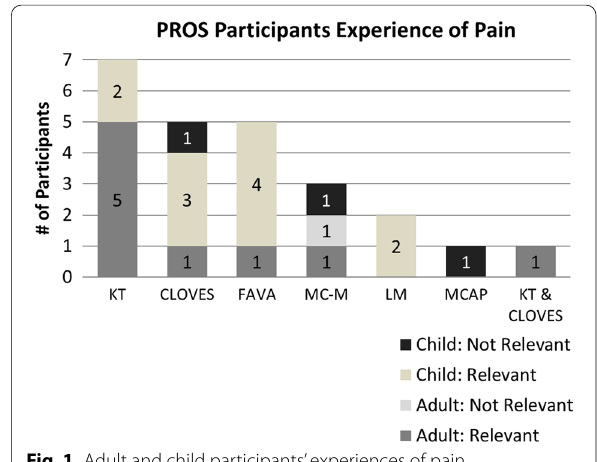
Fig. 1 Adult and child participants’ experiences of